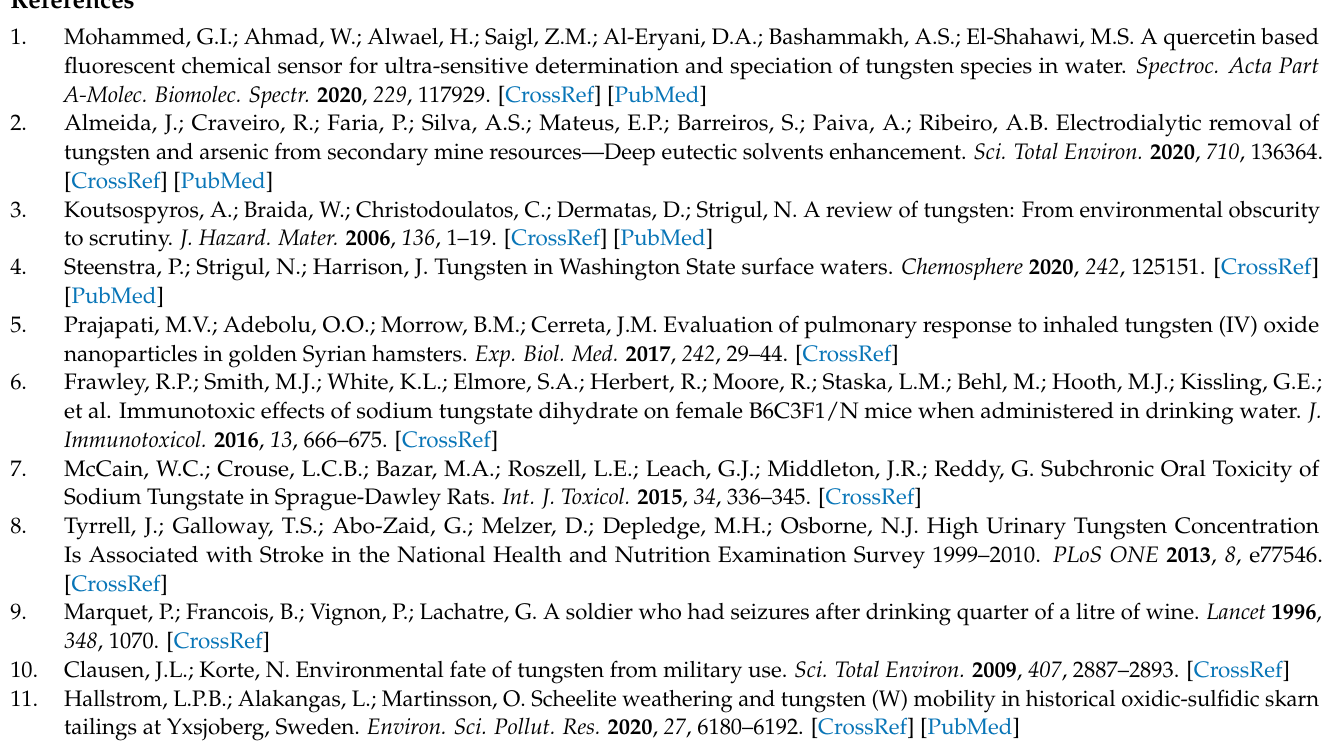
fitting diagram; Figure S4: Experimental results of tungsten removal by hydrocalumite at 25 ◦ C; Table S1: Experimental results of tungsten removal by hydrocalumite at 25 ◦ C; Table S2: Solubility product constants (KSP) for the mineral phases involved in the PHREEQC modeling; Table S3: Results of EDX analysis of elemental composition for solid samples recovered from tungsten removal experiments; Table S4: Fitting parameters for Ca 2p3/2; Table S5: Solubility product constants (KSP) for the mineral phases involved in the PHREEQC modeling. Refs. [34,35] are cited in the supplementary